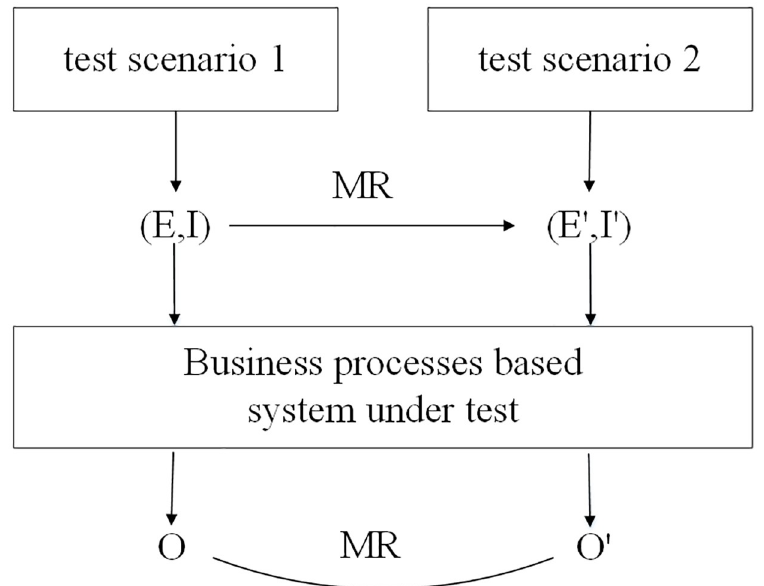
Fig 6. The procedure of testing business processes via MTES.